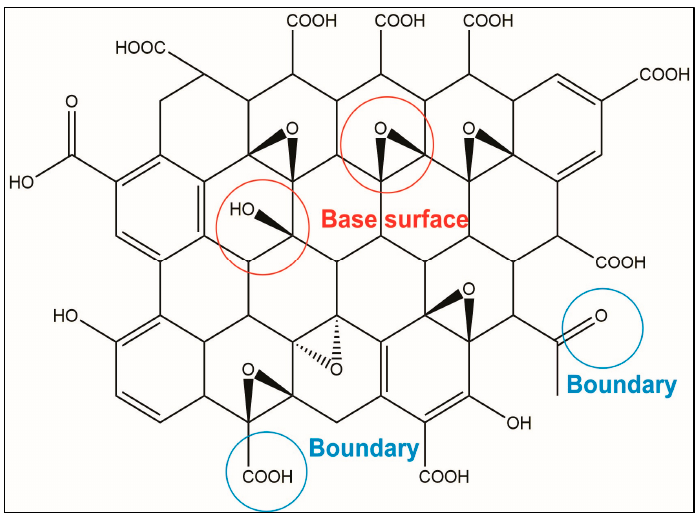
Figure 2. Schematic reaction mechanism of PGE reduction by hydrazine hydrate.